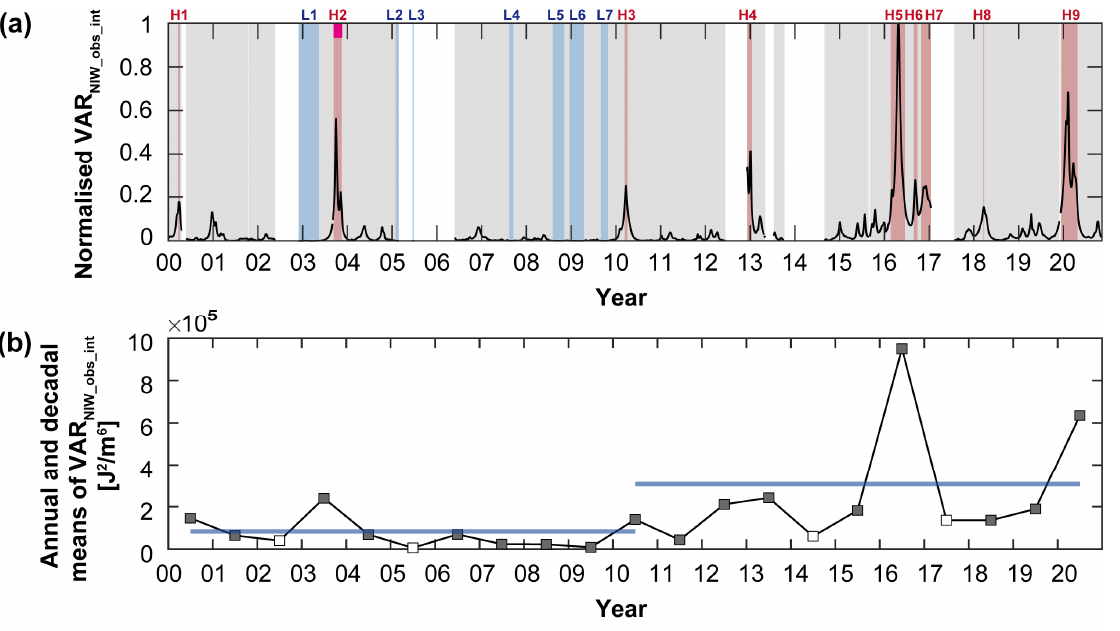
Figure 7. ( a ) Time series of normalised intraseasonal variations in KE NIW at 400 m (VAR NIW_obs_int ) from 2000 to 2020. Red (blue) shaded boxes indicate period high (period low) and grey shaded area indicates period neutral. White area represents the data gap (no data available). Events 2–4 in Noh and Nam [40] are marked at the top of H2 (pink). ( b ) Annual (squares) and decadal mean (blue thick lines) of VAR NIW_obs_int . In ( b ), grey and white squares indicate annual mean values of years in which the data acquisition rate was more and less than 50%.